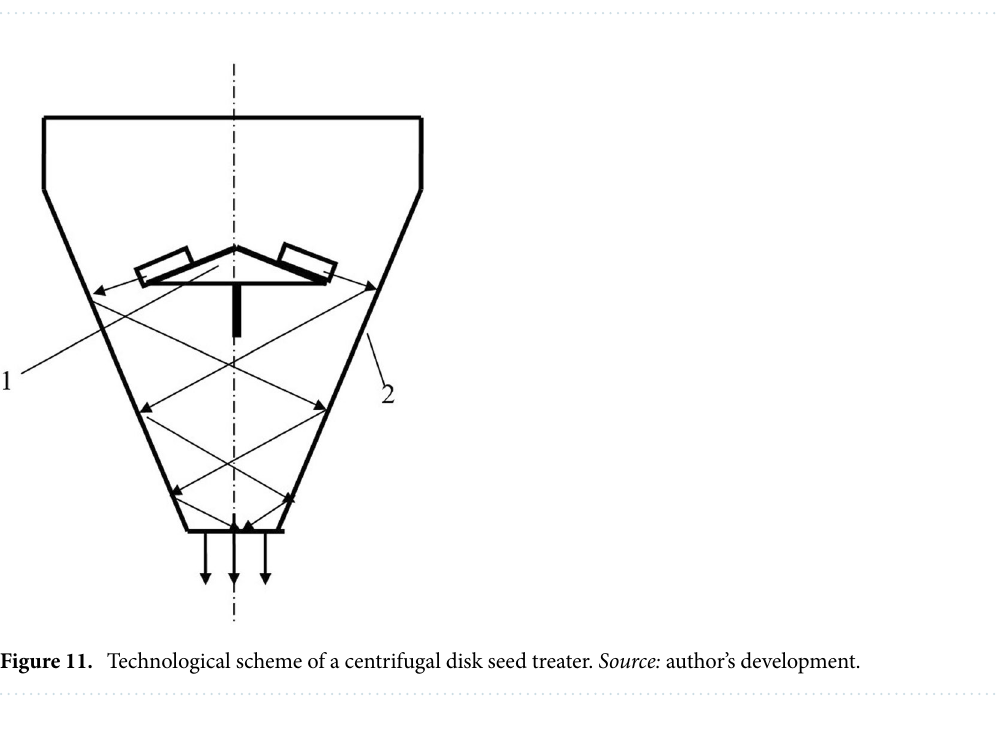
Figure 10. Distribution of seeds over compartments between the blades on the coinciding rotation move. Source: author’s development.